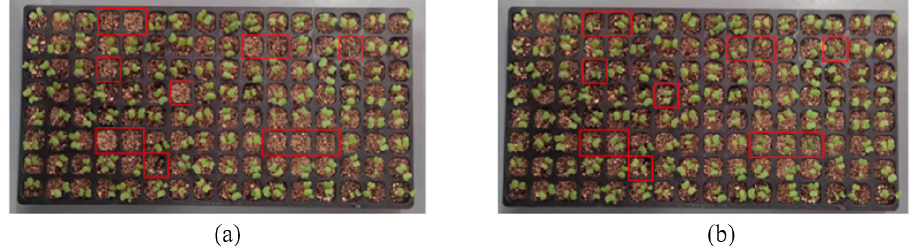
Figure 18. Comparison of effects before and after transplanting: ( a ) tray condition before transplant- ing and ( b ) tray condition after transplanting.